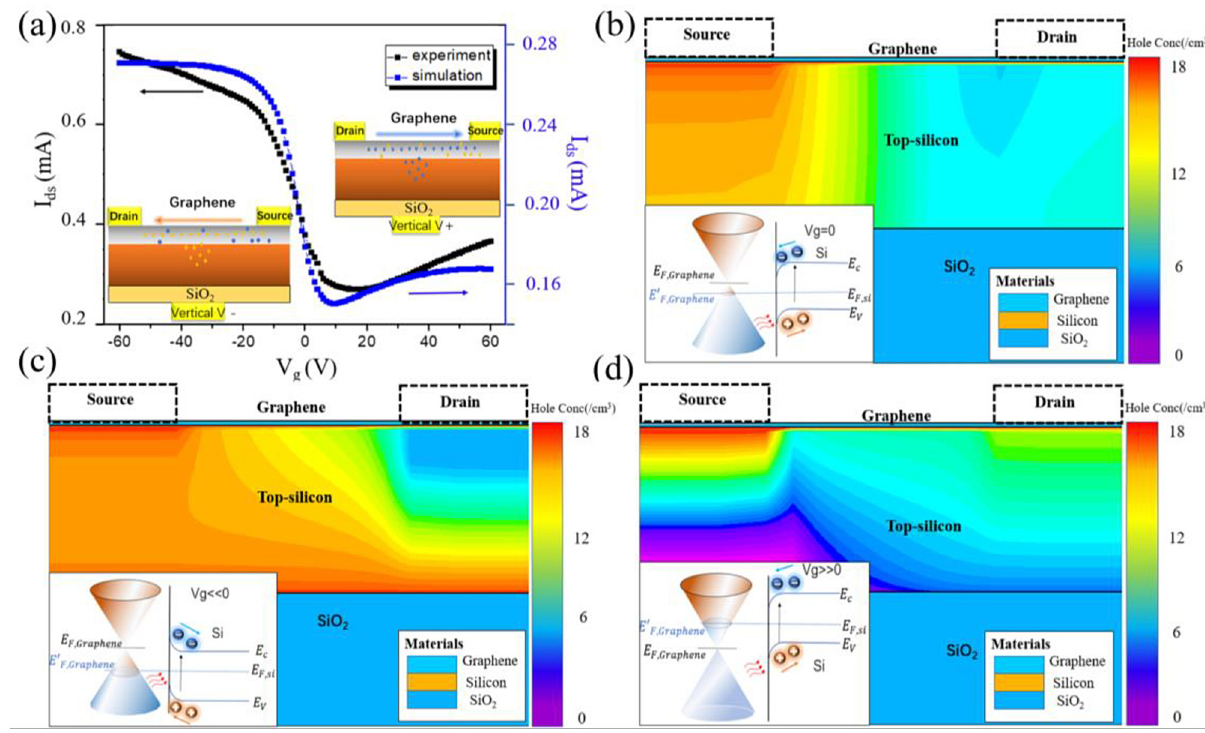
Figure 3: (a) Experimental (black line) and simulated (blue line) transfer characteristics in the dark state. The insets are the corresponding schematic views of the carrier transport under the positive and negative voltages. (b) – (d) Simulated holes distribution in silicon when V g = 0, − 30 and 30 V. Insets are the energy band